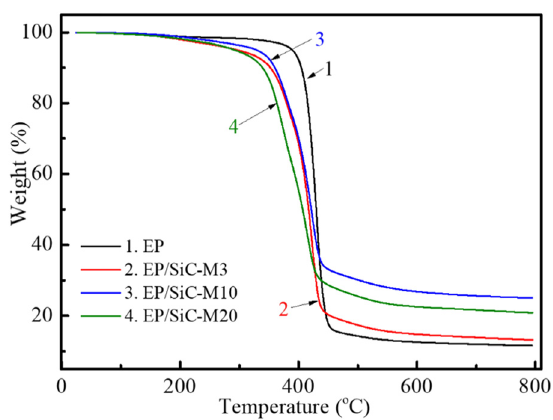
Figure 5: TGA curves of EP and composites EP/SiC - M.